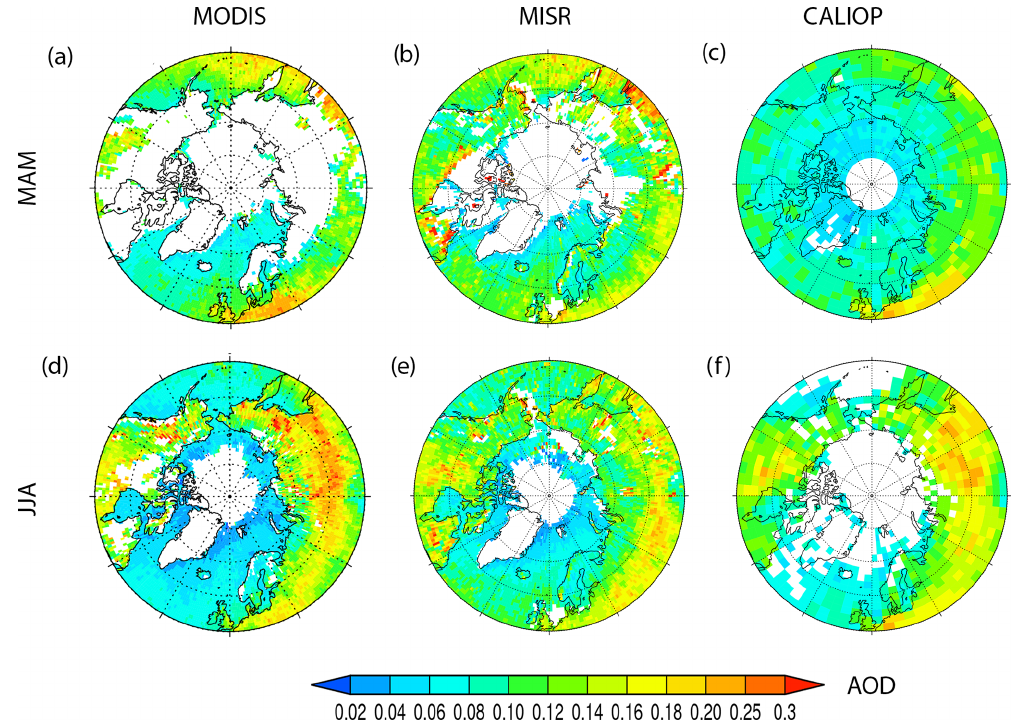
Figure 3. Satellite-derived, mean climatological MAM (a–c) and JJA (d–f) MODIS AOD at 550nm (a, d) , MISR AOD at 558nm (b, e) , and CALIOP AOD at 532nm (c, f) . The averaging period for MODIS and MISR was 2003–2019, while the CALIOP period was 2006–2019. The white areas correspond to a lack of data. The latitude circles are at 50, 60, 70, and 80 ◦